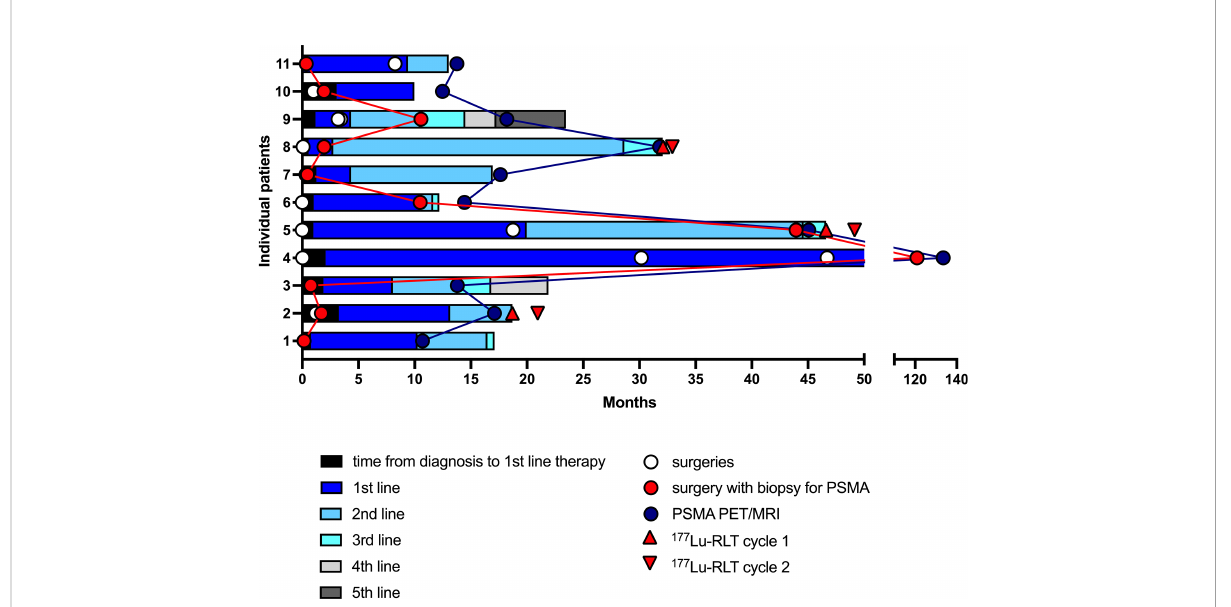
FIGURE 3 Swimmer plot showing the time interval between the biopsy with immunohistological PSMA staining and the PSMA PET/MRI in the context of previous therapies and surgeries of the eleven patients with available histological PSMA staining. Each section of the stacked columns re fl ects the period from beginning a therapy until initiation of the next line therapy. PSMA, prostate speci fi c membrane antigen; 177 Lu-RLT, [ 177 Lu]Lu- PSMA RLT.